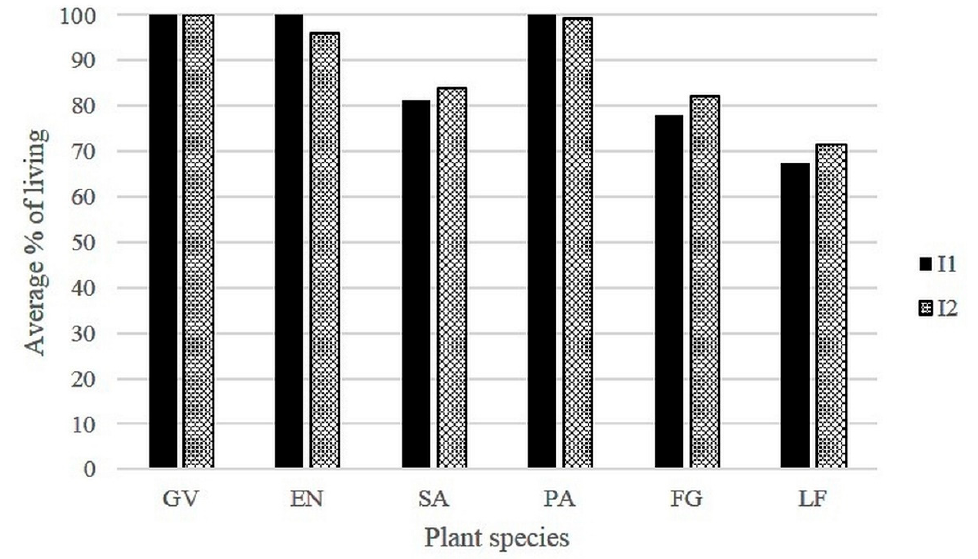
Figure 3. Average percentage of living recorded for plants at the end of the experiment (descriptive analysis).